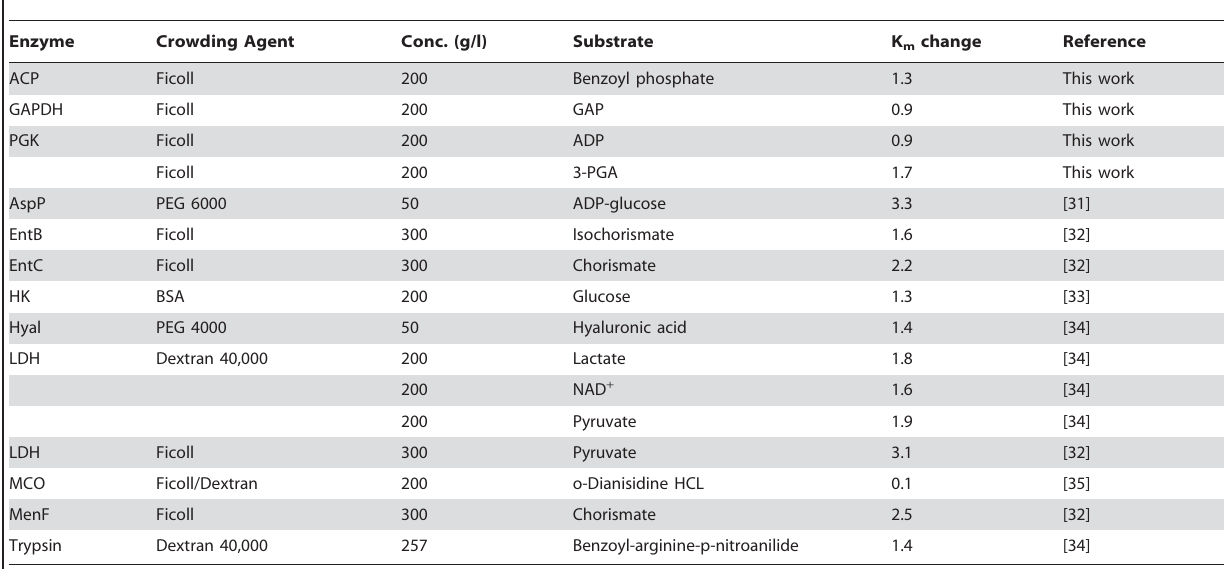
Table 2. Crowding agent effects on the kinetic parameter, K m , of different enzymes.